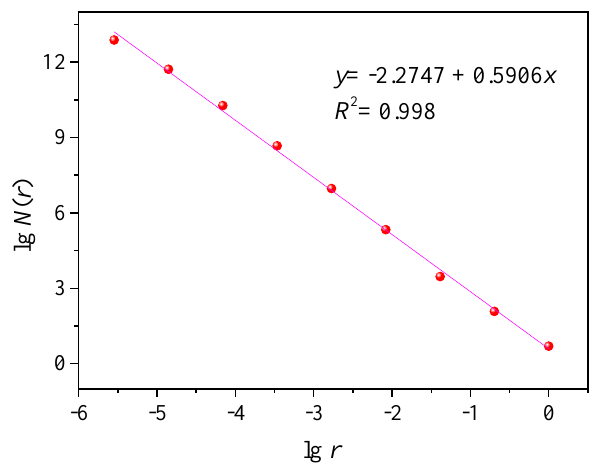
Figure 11. Fitted curve of the fractal dimension obtained via the box-counting method.